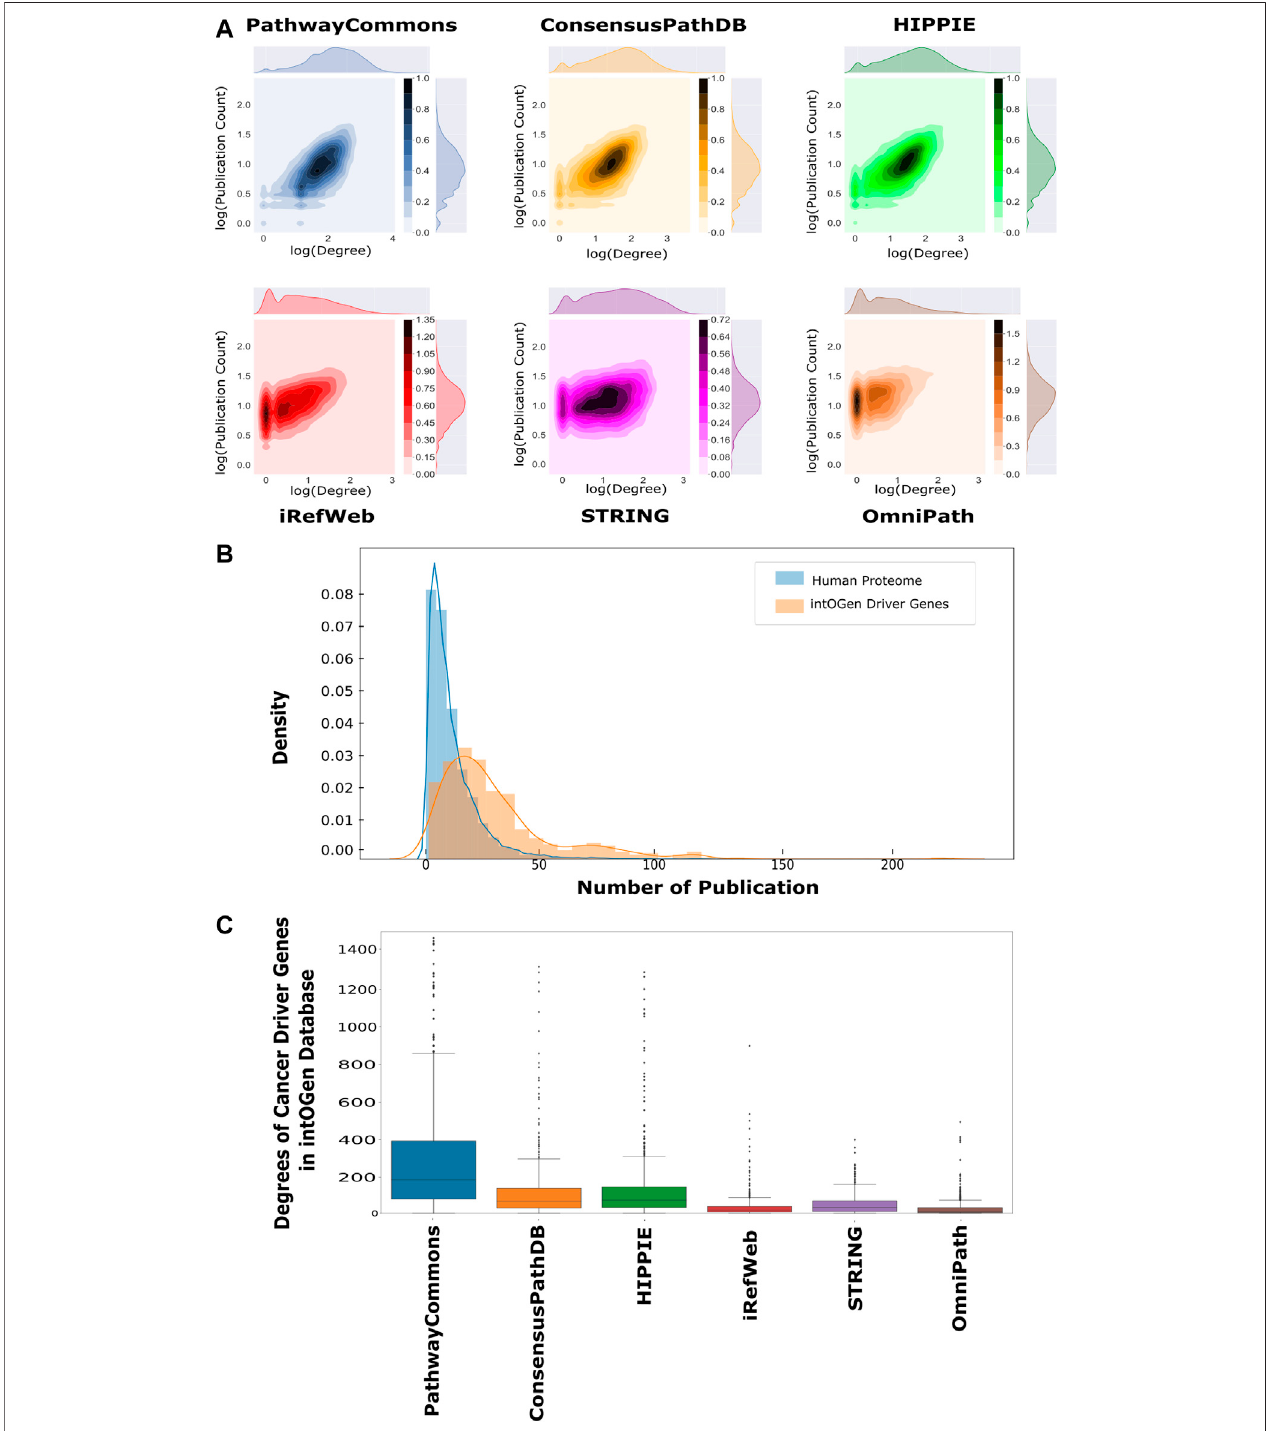
FIGURE 3 | Correlation between publication counts and degrees over interactomes. (A) Log – log scale joint graphs of publication distribution and degree distribution for each interactome were drawn since both follow a power-law distribution. While all interactomes have a positive correlation between the degree and publication number, PathwayCommons, HIPPIE, ConsensusPath, and iREF have well-studied hubs. On the other hand, hubs in iRefWeb and OmniPath are not composed of relatively well-studied proteins (p-values < 0.001 and r PathwayCommons (cid:2) 0.622, r ConsensusPathDB (cid:2) 0.556, r HIPPIE (cid:2) 0.614, r iRefWeb (cid:2) 0.508, r STRING (cid:2) 0.250 and r OmniPath (cid:2) 0.400). (B) Distributions of the number of publications and cancer driver genes in the intOGen database are shown, respectively, in blue and orange. The probability of well-studied cancer driver genes (CDGs) is higher than the probability of well-studied proteins. (C) Driver gene degrees in the interactomes are demonstrated in the boxplot in which driver genes in PathwayCommons have more connection than other interactomes. OmniPath and iRefWeb do not have highly connected driver genes as many as ConsensusPath, HIPPIE, STRING, and PathwayCommons.